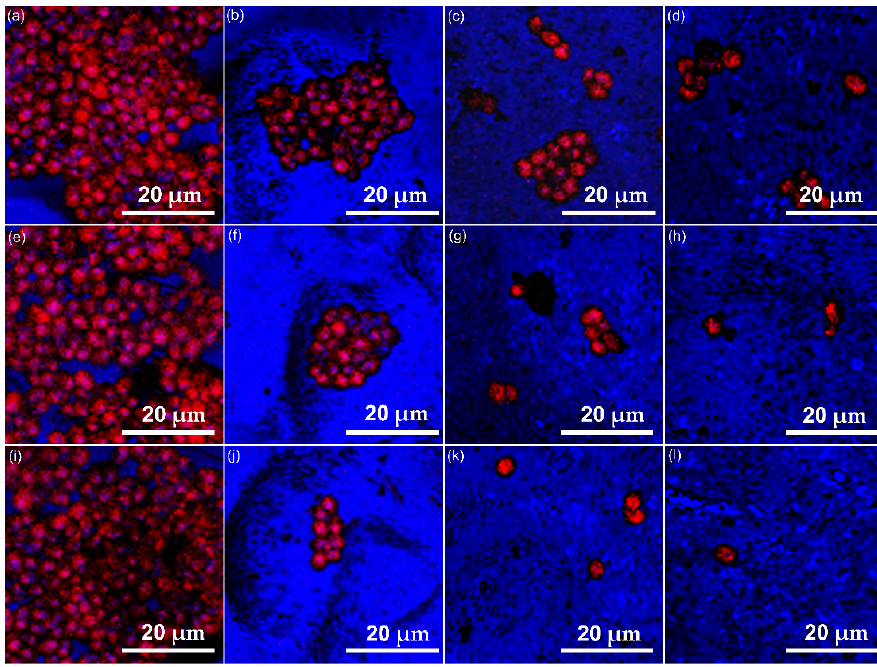
Figure 10. Two-dimensional CLSM images of Candida albicans ATCC 10231 cell development on Si discs ( a , e , i ), HApCh ( b , f , j ), 8MgHApCh ( c , g , k ) and 30MgHApCh ( d , h , l ) composite layers after 24, 48 and 72 h of incubation.